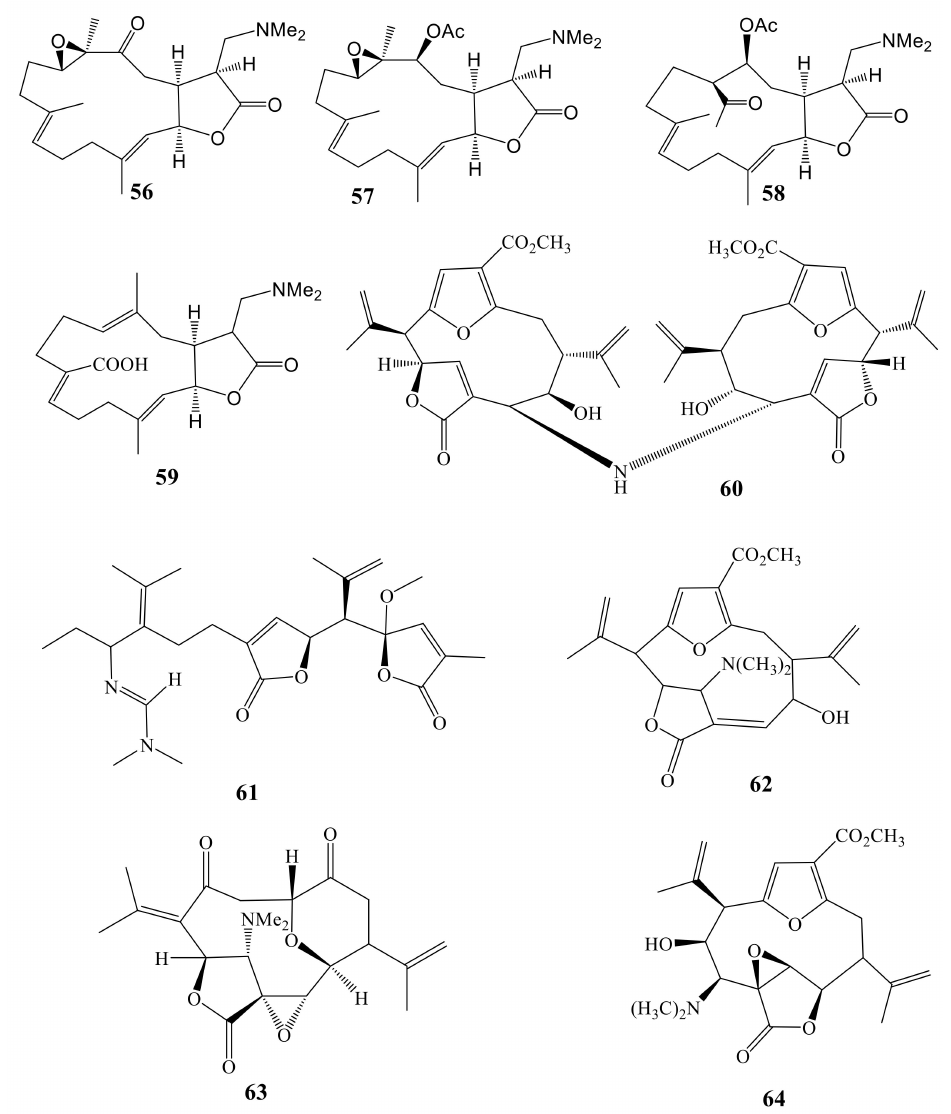
Figure 6. N-Containing diterpenes ( 56 – 64